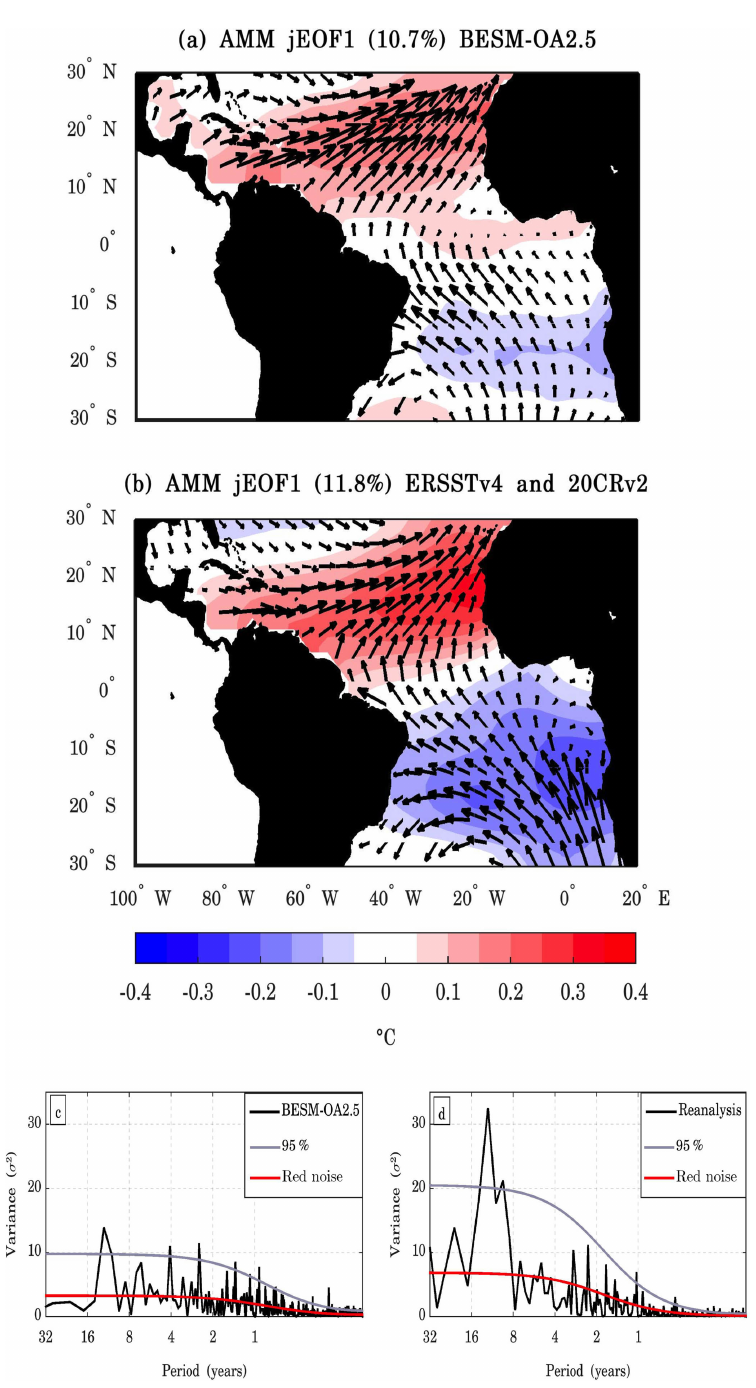
Figure 18. The leading joint EOF modes of the detrended monthly SST and wind stress (Taux and Tauy) anomalies for the tropical Atlantic region (30 ◦ S–30 ◦ N, 100 ◦ W–20 ◦ E) based on (a) BESM-OA2.5 and (b) from observation (ERSSTv4 and 20CRv2 reanalysis). The results are shown as the SST anomalies regressed onto the corresponding normalized PC time series (degrees Celsius per standard deviation) and wind stress anomalies regressed onto the corresponding normalized PC time series (meters per second per standard deviation) over the period 1950–2005. The percentages of the variance explained by each EOF are indicated in the titles of the figures. The contour interval is 0.05 ◦ C. Panels (c) and (d) show the power spectra of the leading joint PC time series of the AMM pattern simulated by BESM-OA2.5 and based on reanalysis, respectively. The solid red line represents the theoretical red noise spectrum and the gray line represents the 95% confidence